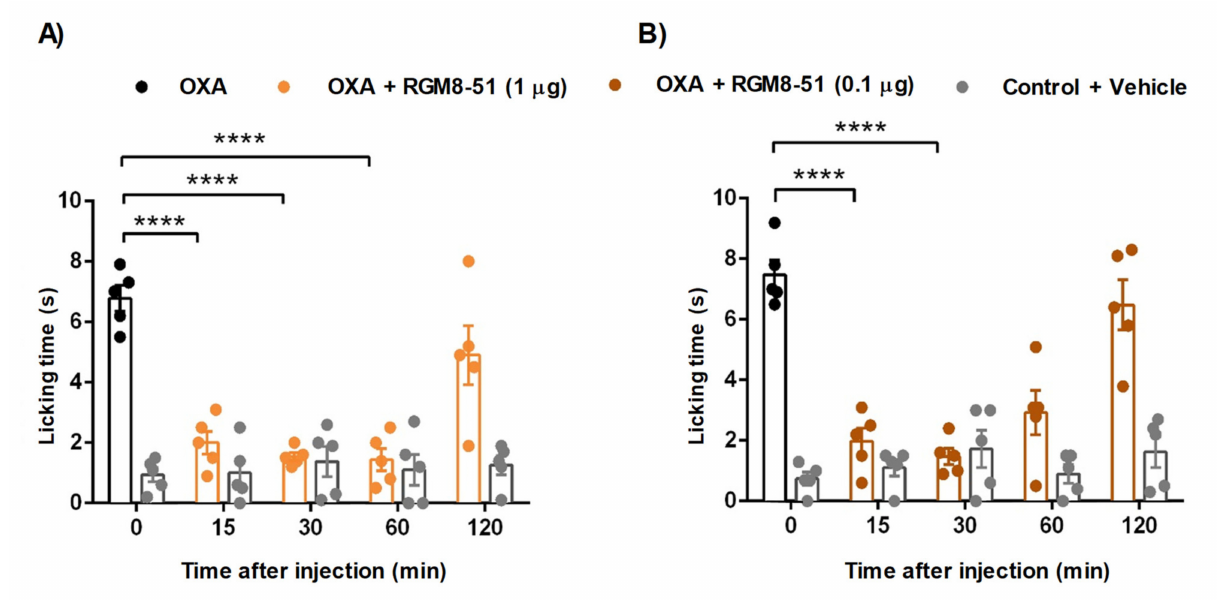
Figure 6. Effects of compound RGM8-51 on the oxaliplatin (OXA)-induced cold hypersensitivity (drop acetone test). Peripheral neuropathy was induced in male mice by injecting OXA (6 mg/kg, s.c.) on days 1, 3 and 5. Control animals were treated with vehicle. Compound RGM8-51 (1 µ g/i.pl., ( A ) or 0.1 µ g/i.pl., ( B )) was administered to the OXA-treated animals, and the time-course of cold hypersensitivity was measured. Data are given ± SEM (n = 5). Statistical analysis, comparing with oxaliplatin-treated mice, was performed by two-way ANOVA followed by post hoc Bonferroni test by multiple comparisons: **** p <